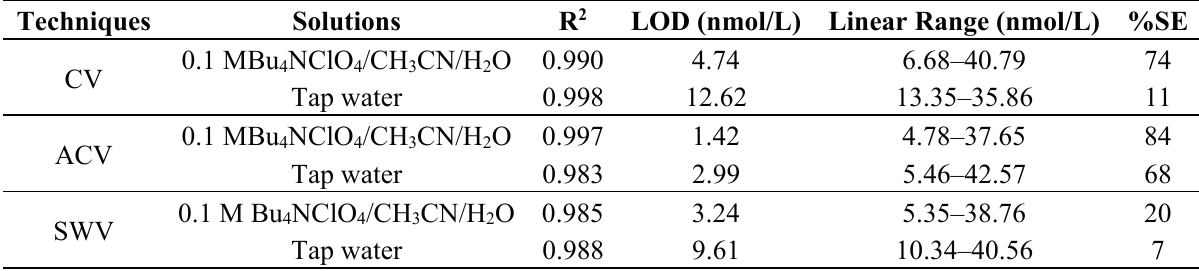
Table 1. CV, ACV and SWV parameters of the Au|G3PPT-co-P3HT phenanthrene sensor